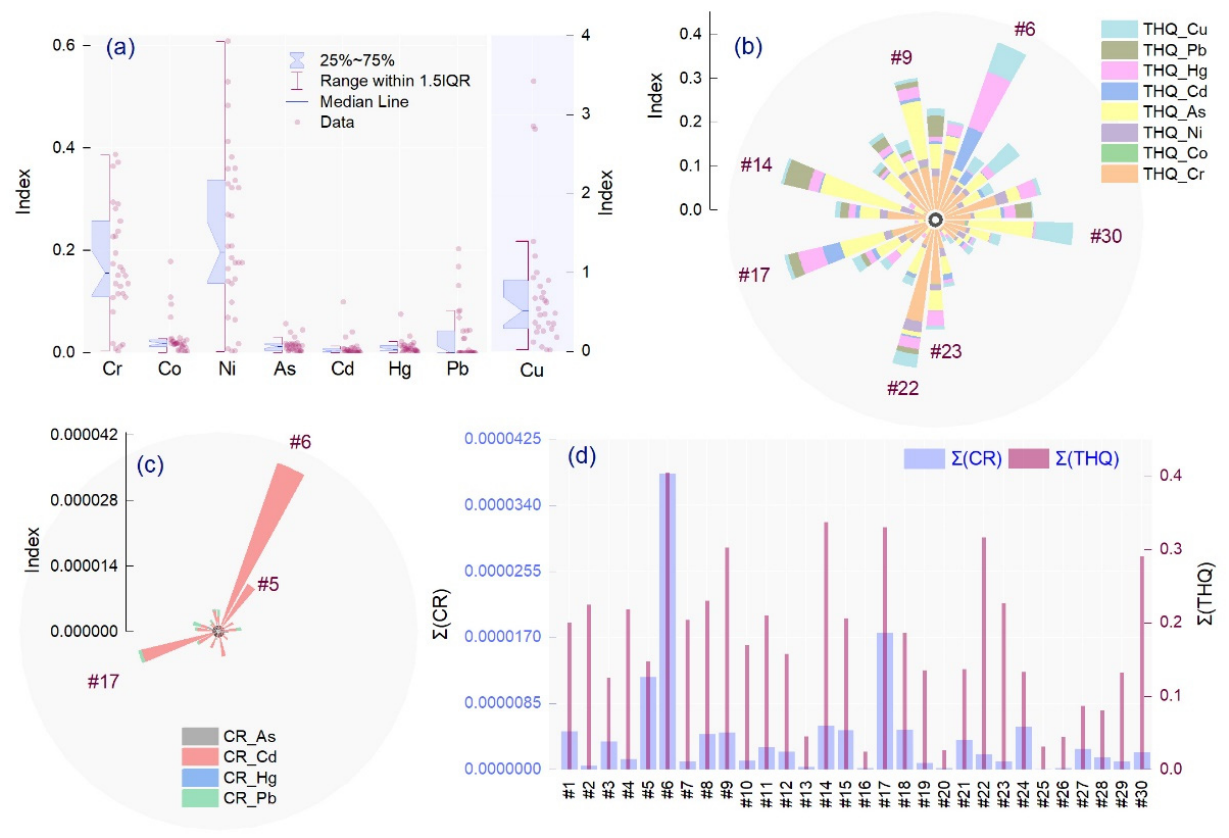
Figure 4. The graphical representation of ( a ) estimated daily intake (EDI), ( b ) Target Hazard Quotient (THQ), ( c ) Cancer Risk (CR), and ( d ) sum of Cancer Risk and Target Hazard Quotient.